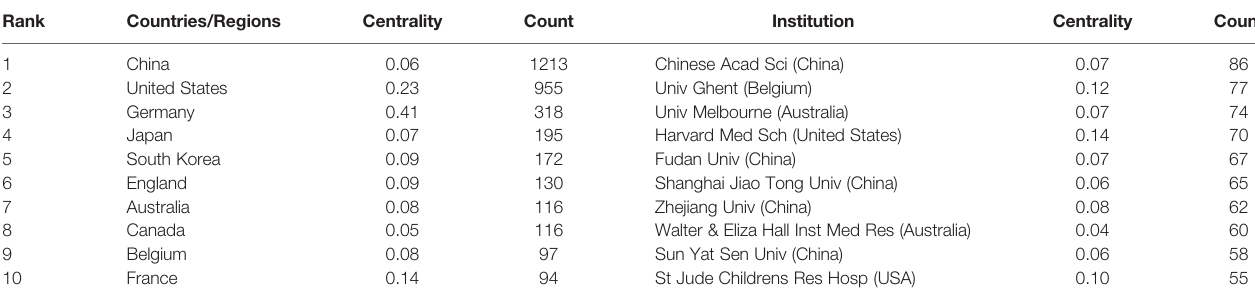
TABLE 1 | Top 10 countries/regions and institutions related to necroptosis.